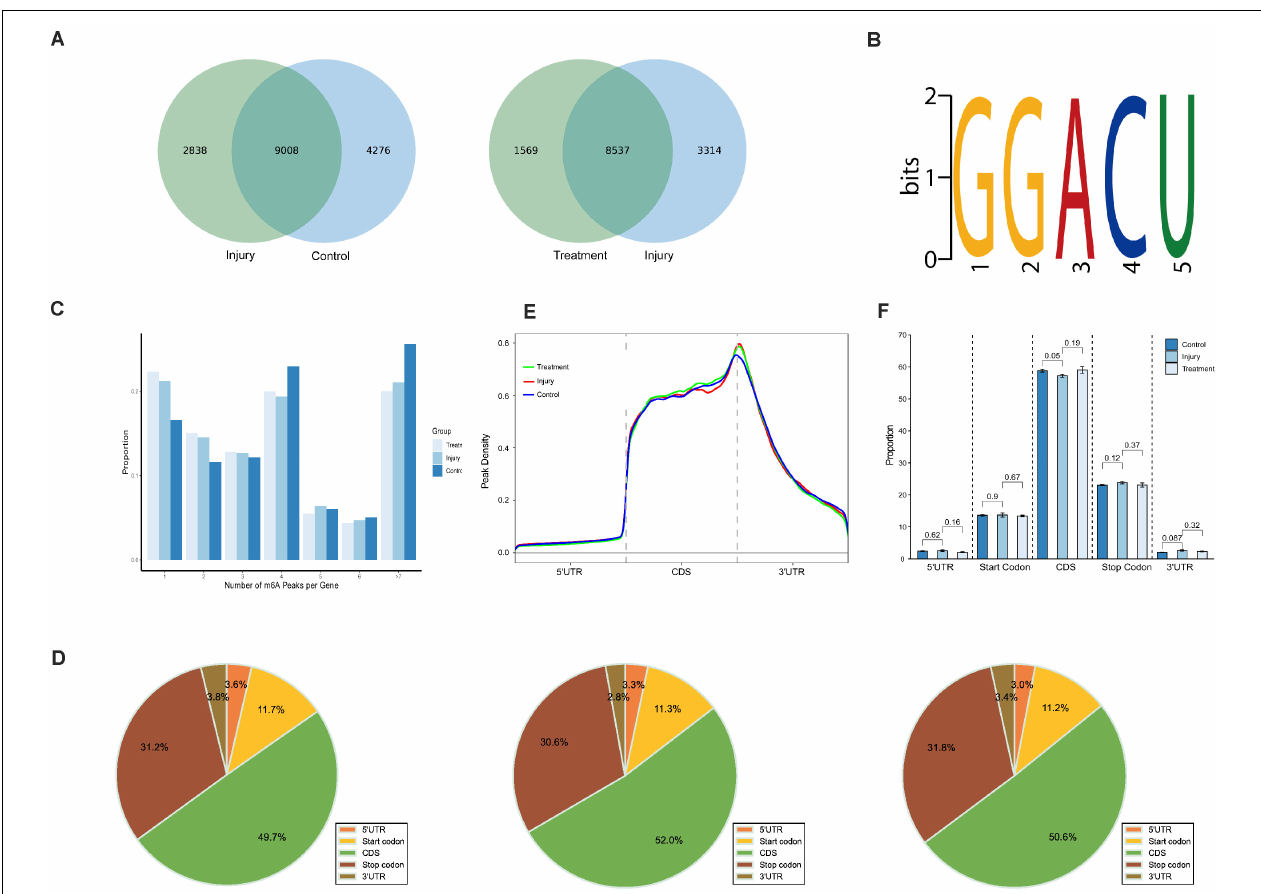
FIGURE 2 | Overview of N6-methyladenosine methylation within mRNAs in the control, injury, and treatment groups. (A) Venn diagram showing the overlap of m6A peaks within mRNAs between IvC (left) and TvI (right). (B) The top motif enriched across m6A peaks identified from three groups. (C) Proportion of genes harboring different numbers of m6A peaks in three groups. The majority of genes harboring more than one m6A peak. (D) Pie charts showing the percentage of m6A peaks in five segments of transcripts. m6A peaks were most enriched in the coding sequence segment. (E) Distributions of fold enrichment of m6A peaks in five segments. The mean fold enrichment in the stop codon segments was the highest in injury group, while that value in CDS was the largest in treatment group. (F) Analysis of m6A peaks in different groups. Error bars represent the standard deviation. Student’s t -test.